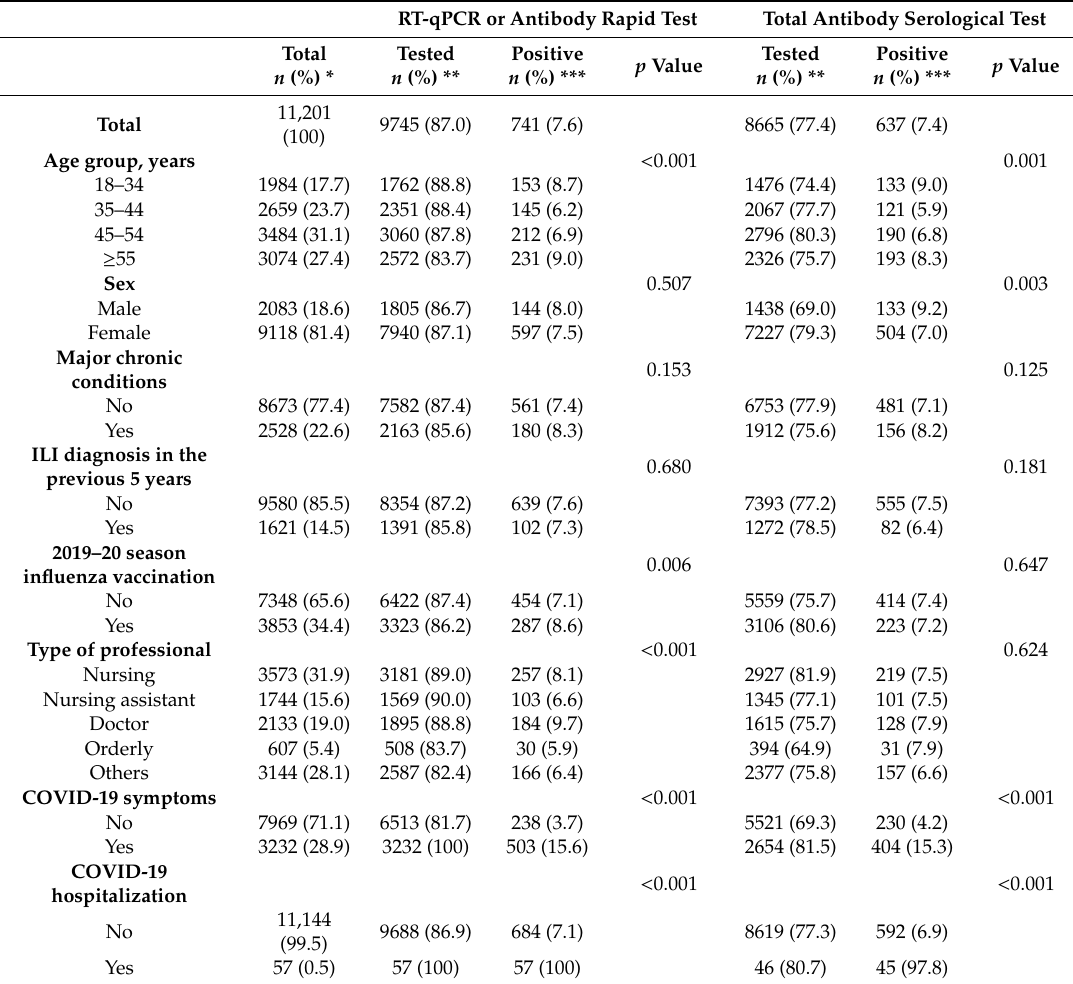
Table 1. Characteristics of health workers according to the SARS-CoV-2 infection diagnosis by type of test. RT-qPCR or Antibody Rapid